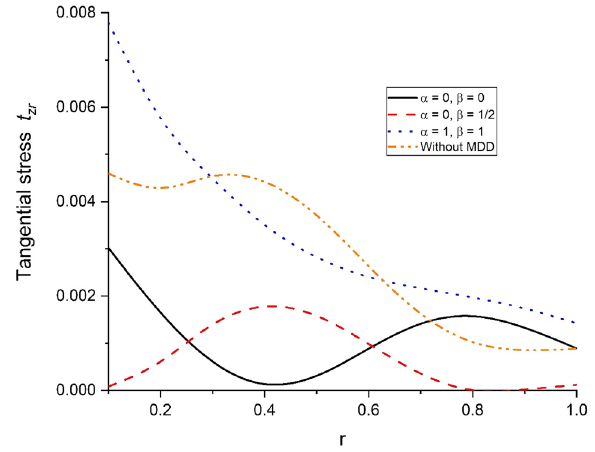
Fig. 4 Variations of tangential stress t zr with radius r